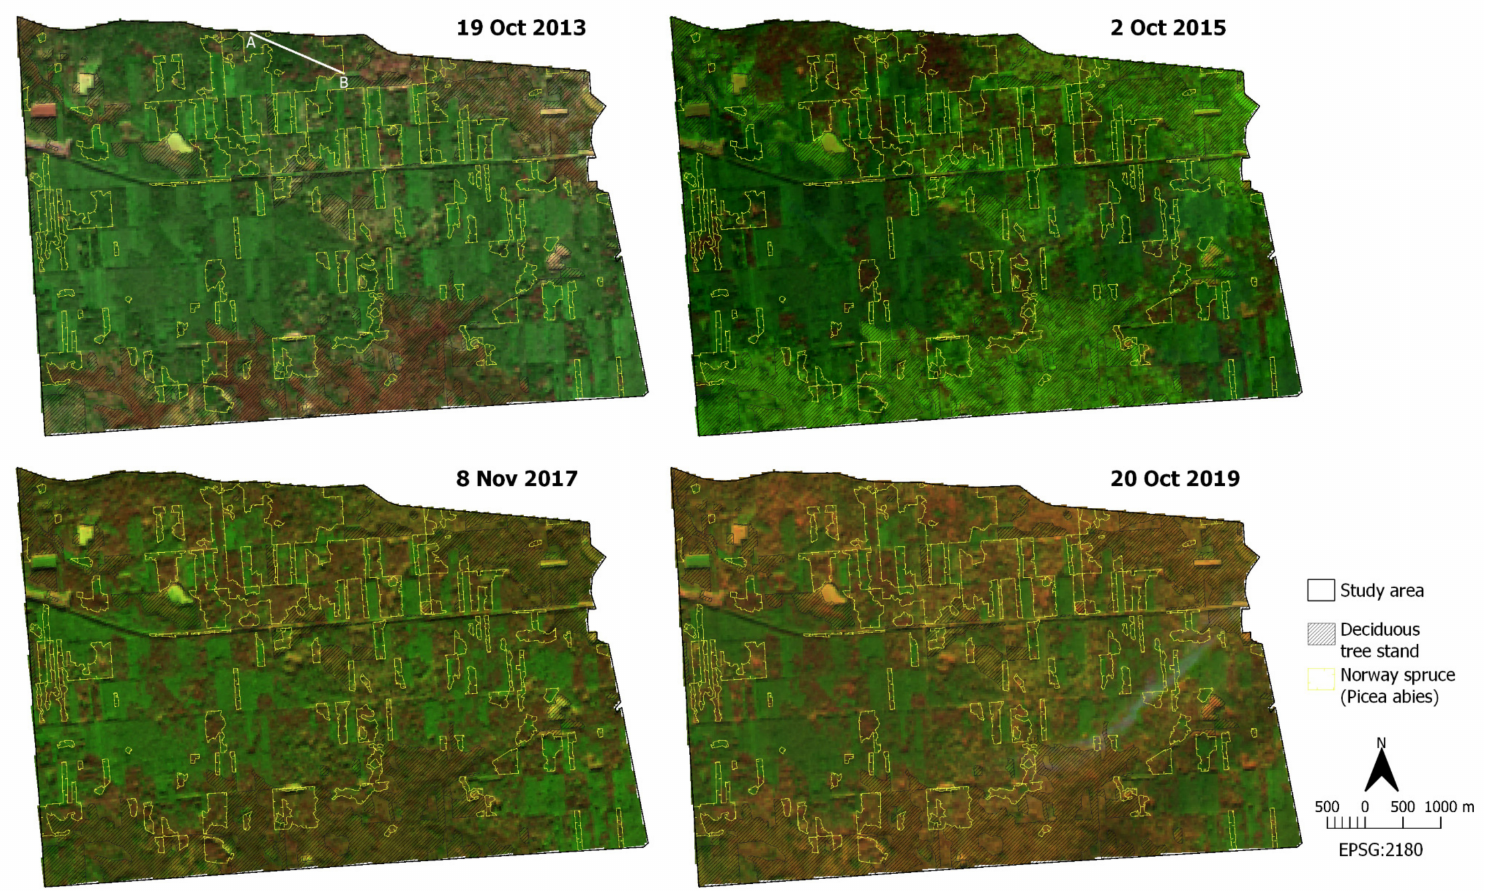
Figure 2. Landsat 8 6-5-3 (SWIR-NIR-G) false colour composite for the study area in 2013, 2015, 2017, and 2019. A–B (white solid line)—a transect for reflectance charts (see Figure 3). Landsat Surface Reflectance products courtesy of the U.S. Geological